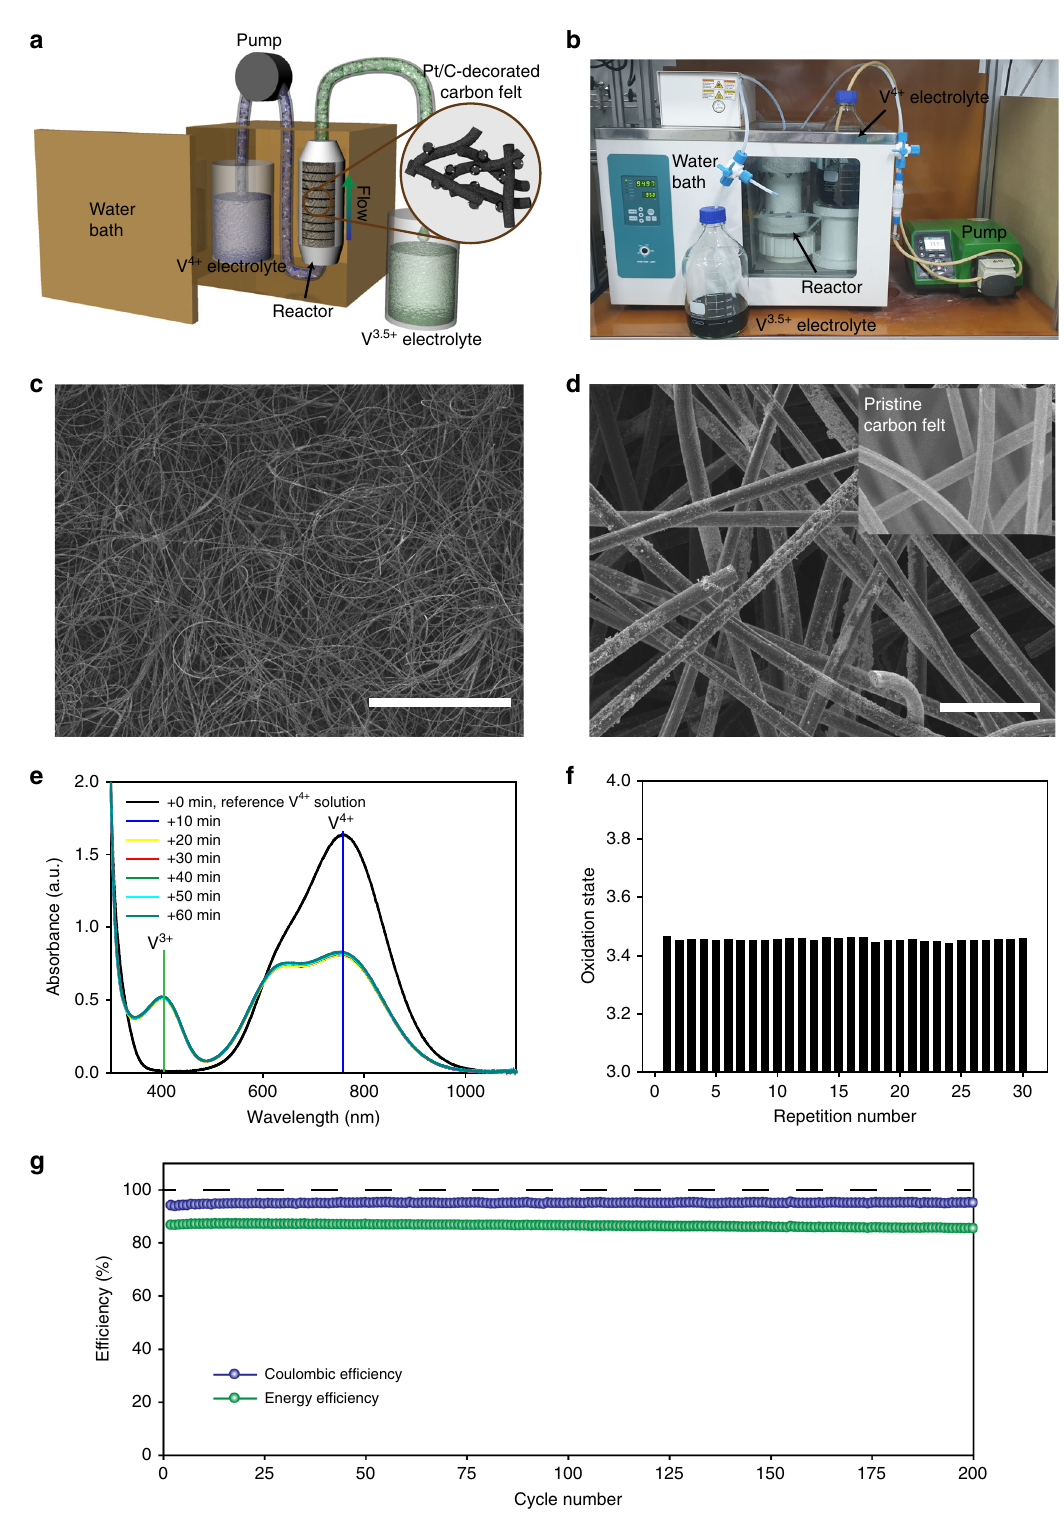
Fig. 6 Continuous production of the V 3.5 + electrolyte by the catalytic reactor. a Structure and b optical image of the catalytic reactor. Scanning electron microscopy (SEM) image of the Pt/C-decorated carbon felt at c low and d high magni fi cation. (Scale bars: c 1 mm, d 50 μ m. Inset: SEM image of the pristine carbon felt in the same scale with ( d )). e Ultraviolet – visible (UV – Vis) spectra of the feed (V 4 + electrolyte) and product electrolytes taken at different operation times during continuous 2 L h − 1 catalytic reaction. f Oxidation states of the product electrolytes from the 30 repeated operations. g Coulombic and energy ef fi ciencies of the cell with its electrolyte produced using the catalytic